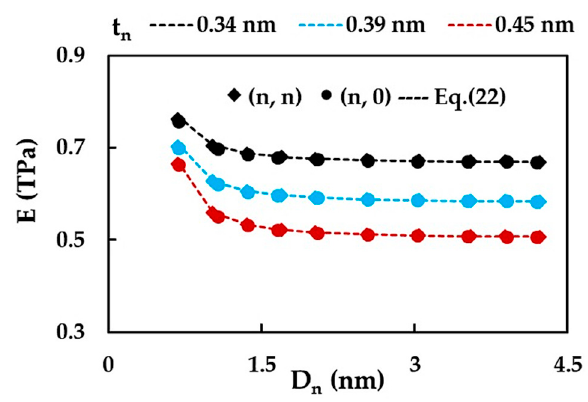
Figure 5. Evolutions of the Young’s modulus, E, with the NT diameter, D n , for SWSiCNTs, considering the NT wall thicknesses, t n = 0.34 nm, 0.39 nm and 0.45 nm.